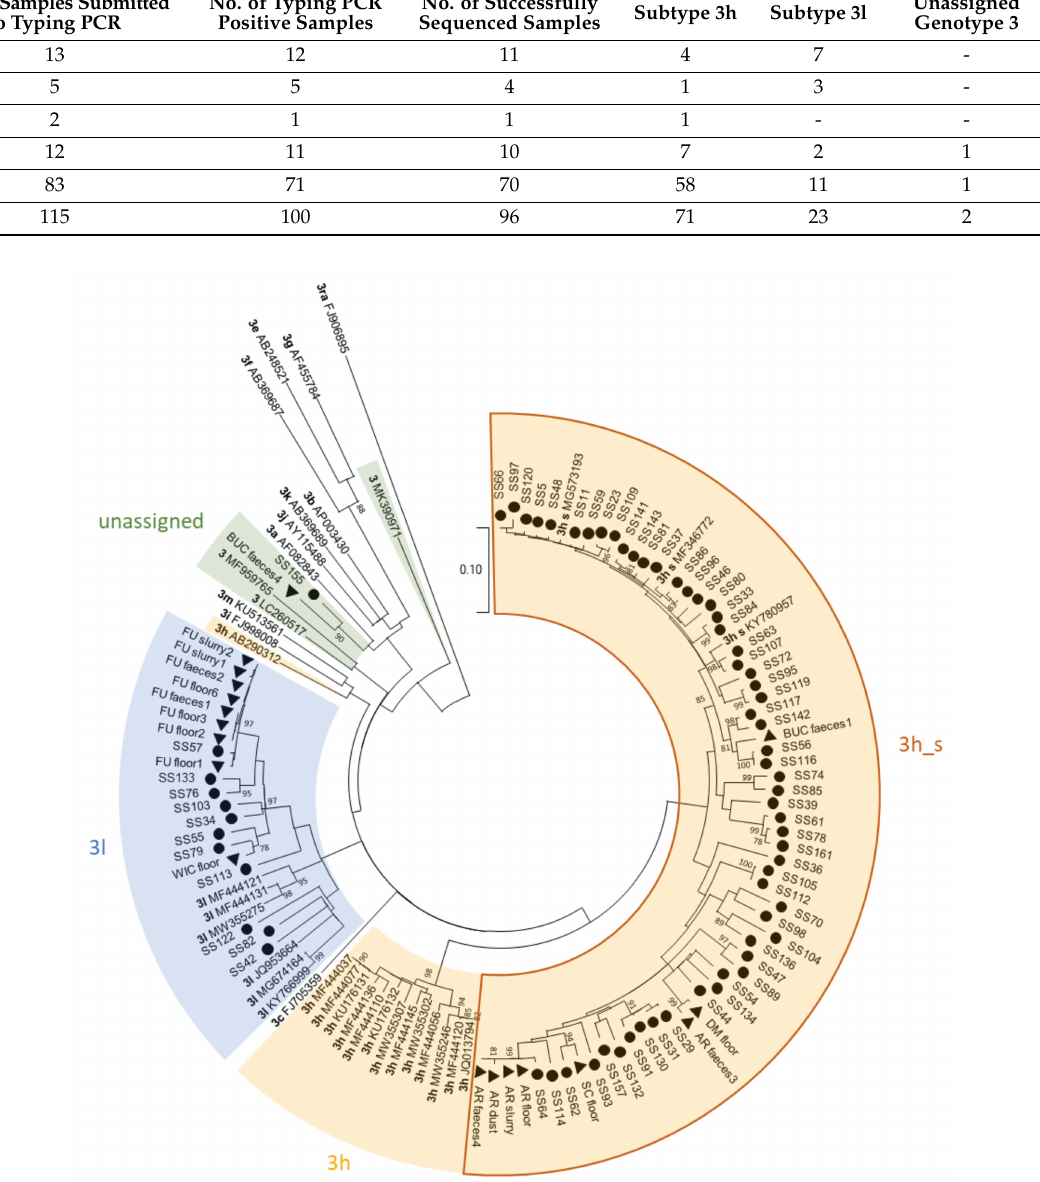
Table 4. HEV subtyping results from the Sanger sequencing of the 493 nt long ORF2 region. Subtypes were assigned with help of the Hepatitis E Virus Genotyping Tool and the phylogenetic tree we constructed. Sample Material